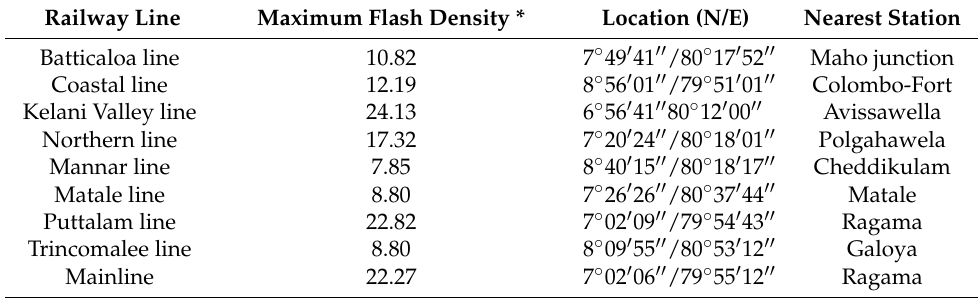
Table 1. Distribution of the maximum annual lightning flash density (flashes/(km 2 · year)) on each line of the railway network of Sri